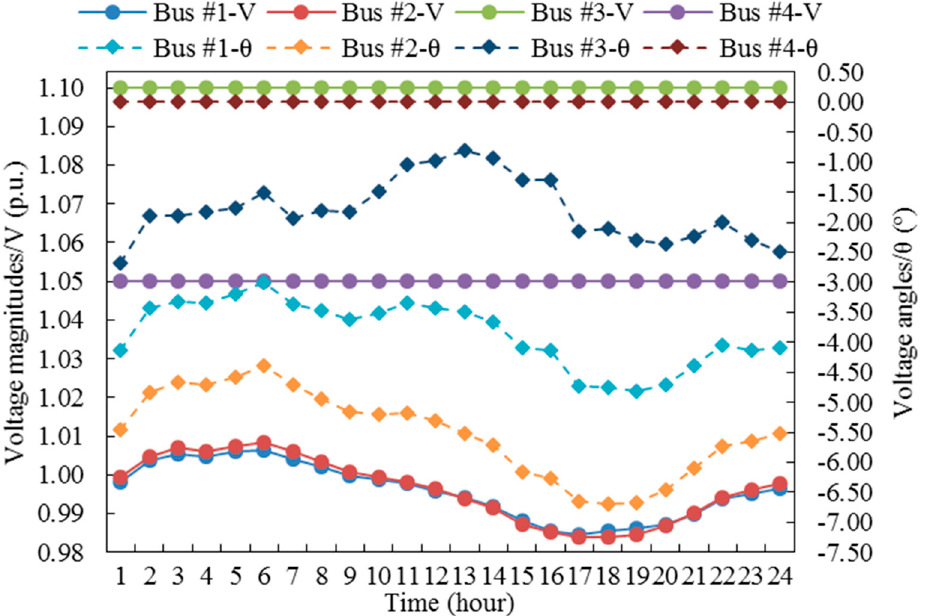
Figure 7. Change of optimal distributive proportion coefficient for EH1 and EH2.